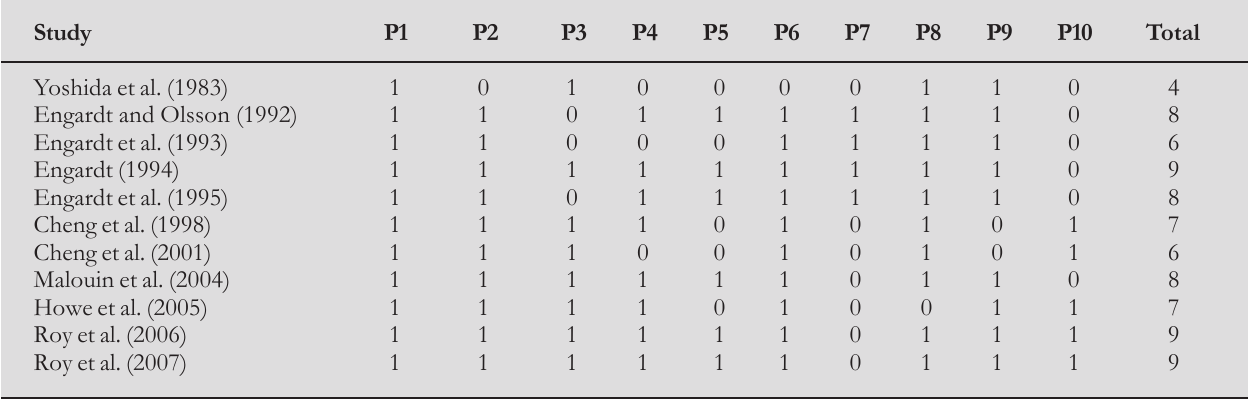
Table 1 - Assessment of the quality of the included studies (n=11)